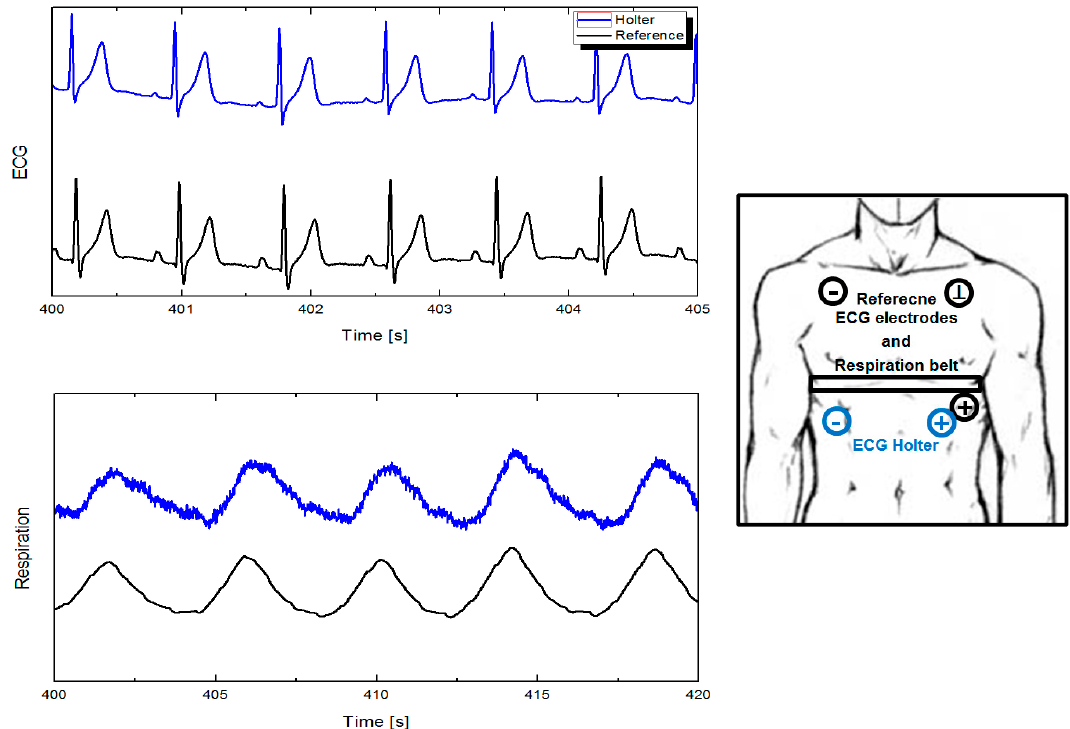
Figure 2. Comparison of ECG and respiration achieved by laboratory instruments and Holter.